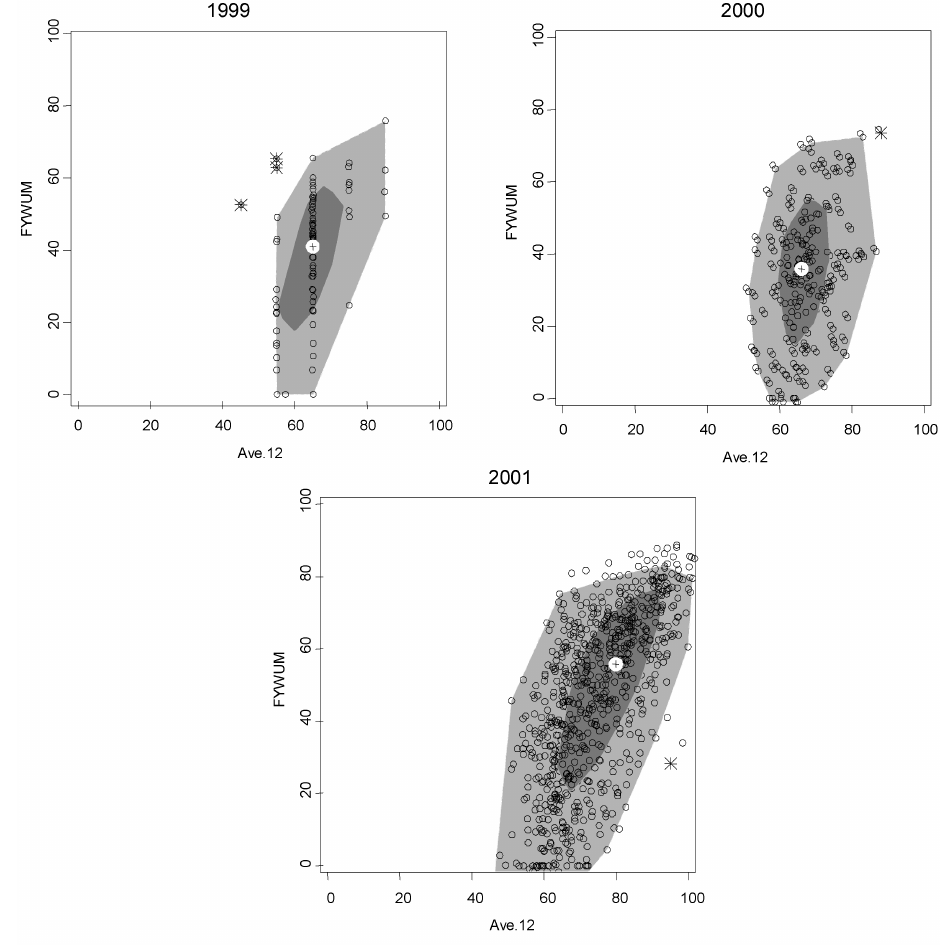
Figure 9: Bagplots of FYWUM and Ave.12 for 1999, 2000 and